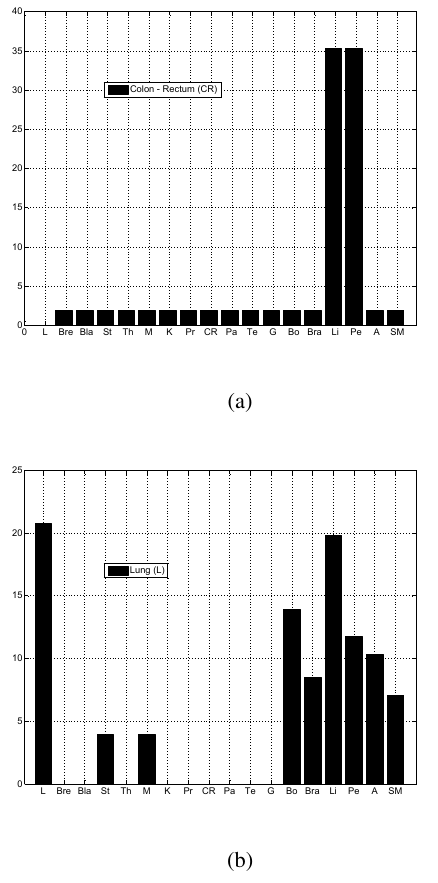
Fig. 4: Probabilities (in percentage) for tumors in tertiary site from (a) Colon/Rectum ( CR ) and (b) Lung ( L ).